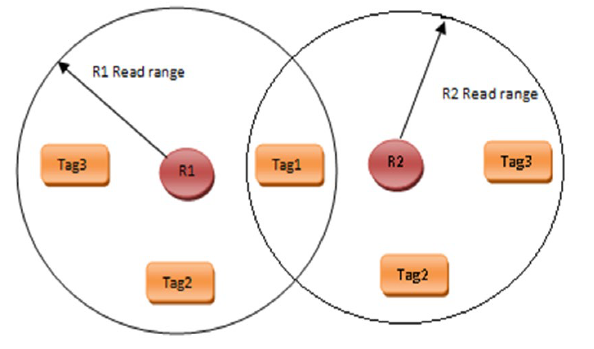
Figure 1. Multiple Reader to Tag Collision